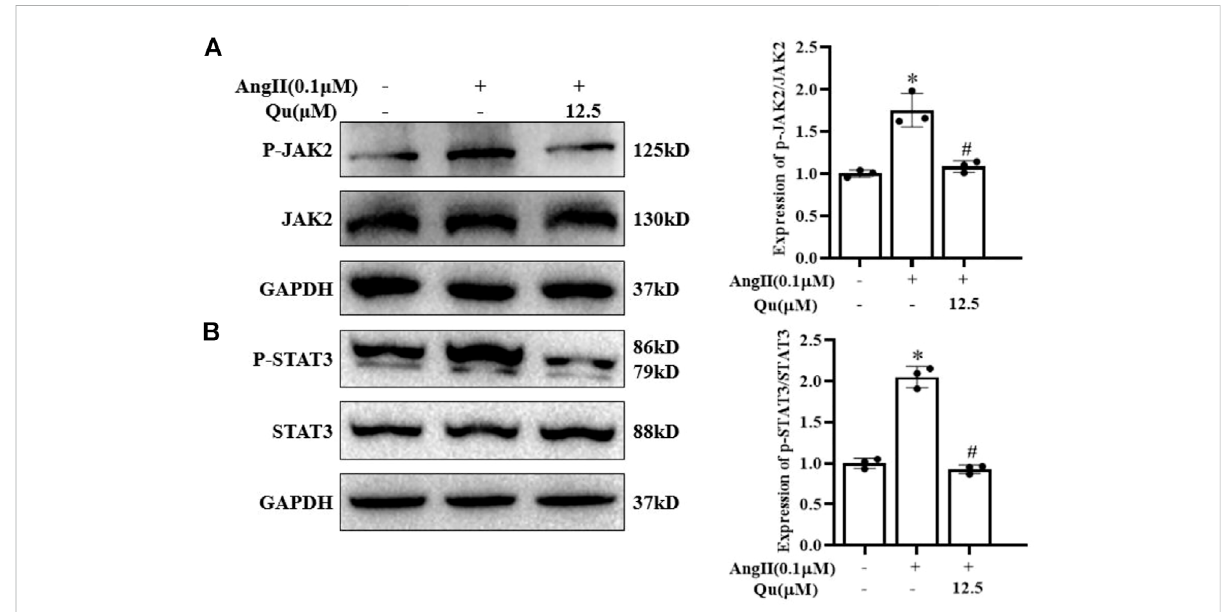
FIGURE 6 Quercetin attenuates angiotensin-II-induced JAK2/STAT3 activation. (A – B) Protein expression of JAK2 and STAT3 along with p-JAK2 and p-STAT3expressionlevelswasanalyzedbywesternblottinginVSMCswithorwithout0.1 µMAngII-induction andquercetin(12.5 µM)treatmentfor 24 h (A) JAK2 and p-JAK2 protein levels in VSMCs Ang II-induced cells treated with quercetin and quanti fi cation of the expression level of p-JAK2/ JAK2 (represented in right panel graph) (B) STAT3 and p-STAT3 protein levels in VSMCs Ang II-induced cells treated with quercetin and quanti fi cation of the expression level of p-STAT3/STAT3 (represented in right panel graph. Data are presented as mean ± SD; n = 3 for in vitro study; * p < 0.05 vs. Control group, # p < 0.05 vs. Ang II